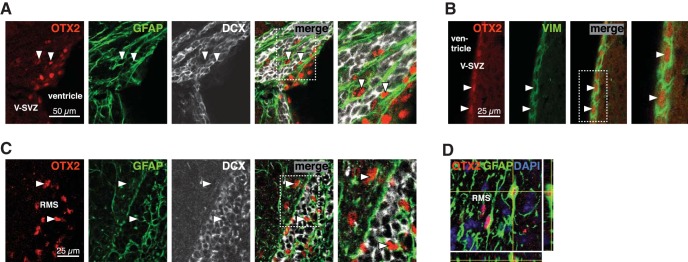
OTX2 transfers into supporting cells of neurogenic niches. A, In dorsal V-SVZ, OTX2 staining is detected in some GFAP-labeled astrocytes but not in DCX-labeled neuroblasts. Arrowheads highlight astrocytes containing OTX2. B, Along the lateral ventricular wall, OTX2 staining is detected in vimentin (VIM)-labeled ependymal cells. C, In the RMS, OTX2 staining is detected in GFAP-labeled astrocytes but not in DCX-labeled neuroblasts. Arrowheads highlight astrocytes containing OTX2. D, Orthogonal projection shows OTX2 in the nucleus of astrocytes within the RMS.